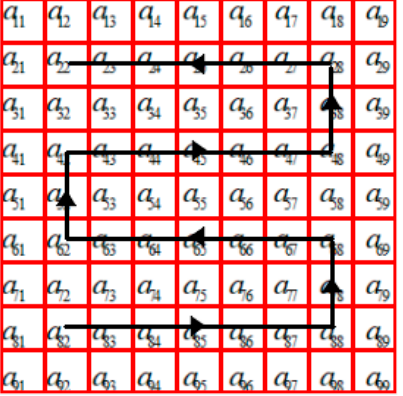
(8) The geological strength index along the cutting path is: 𝑎 (cid:2876)(cid:2870) → 𝑎 (cid:2876)(cid:2871) → 𝑎 (cid:2876)(cid:2872) → 𝑎 (cid:2876)(cid:2873) → 𝑎 (cid:2876)(cid:2874) → 𝑎 (cid:2876)(cid:2875) → 𝑎 (cid:2876)(cid:2876) → 𝑎 (cid:2875)(cid:2876) → 𝑎 (cid:2874)(cid:2876) → 𝑎 (cid:2874)(cid:2875) → 𝑎 (cid:2874)(cid:2874) → 𝑎 (cid:2874)(cid:2873) → 𝑎 (cid:2874)(cid:2872) → 𝑎 (cid:2874)(cid:2871) → 𝑎 (cid:2874)(cid:2870) → 𝑎 (cid:2873)(cid:2870) → 𝑎 (cid:2872)(cid:2870) → 𝑎 (cid:2872)(cid:2871) → 𝑎 (cid:2872)(cid:2872) → 𝑎 (cid:2872)(cid:2873) → 𝑎 (cid:2872)(cid:2874) → 𝑎 (cid:2872)(cid:2875) → 𝑎 (cid:2872)(cid:2876) → 𝑎 (cid:2871)(cid:2876) → 𝑎 (cid:2870)(cid:2876) → 𝑎 (cid:2870)(cid:2875) → 𝑎 (cid:2870)(cid:2874) → 𝑎 (cid:2870)(cid:2873) → 𝑎 (cid:2870)(cid:2872) → 𝑎 (cid:2870)(cid:2871) → 𝑎 (cid:2870)(cid:2870) The cutting head swings along the planned path. The cutting head passes through different grids, and the speed of the cutting head is adjusted according to the geological strength index GSI value in the grid. The speed mode of the cutting head of the roadheader is divided into three modes: high speed, medium speed, and low speed. The